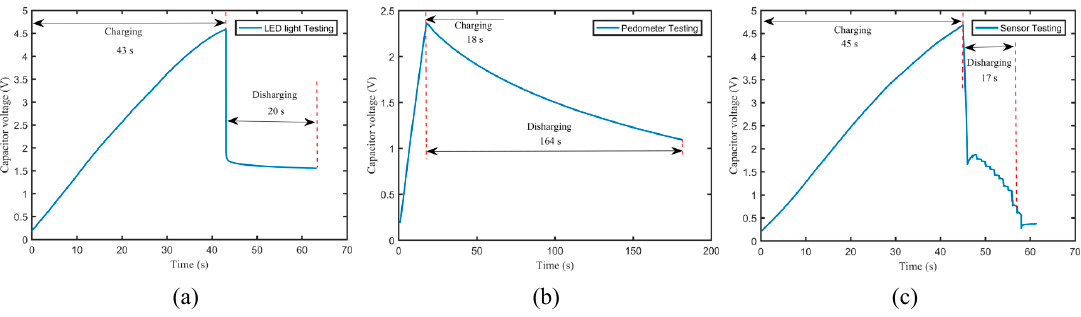
Figure 10. Variation of the capacitor voltage with time for EH-180-1 at 16.32 m/s: ( a ) capacitor voltage for LED light testing; ( b ) capacitor voltage for pedometer testing; ( c ) capacitor voltage for sensor testing.